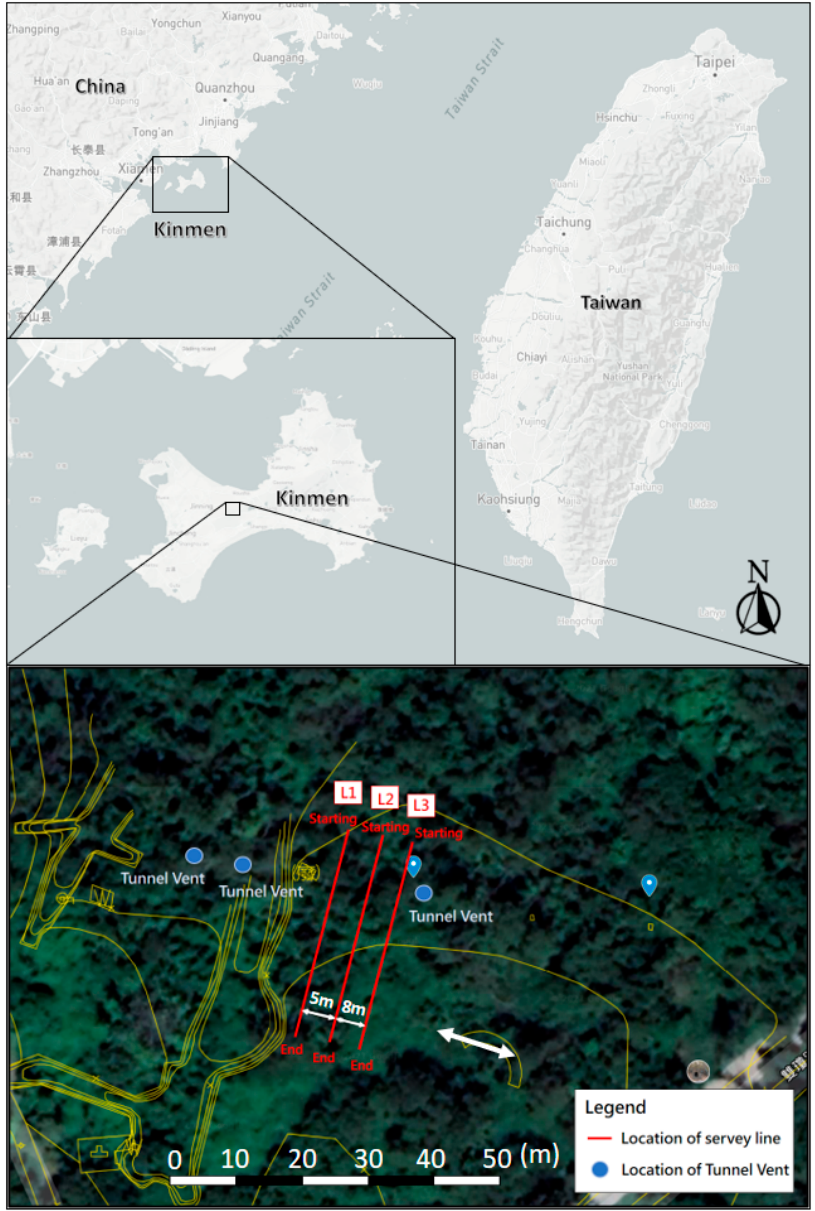
Figure 1. Test site location and measurement wiring